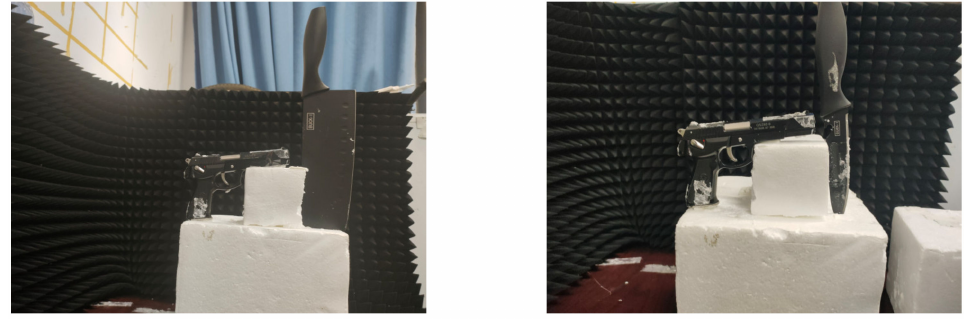
Figure 10. The optical images of multiple